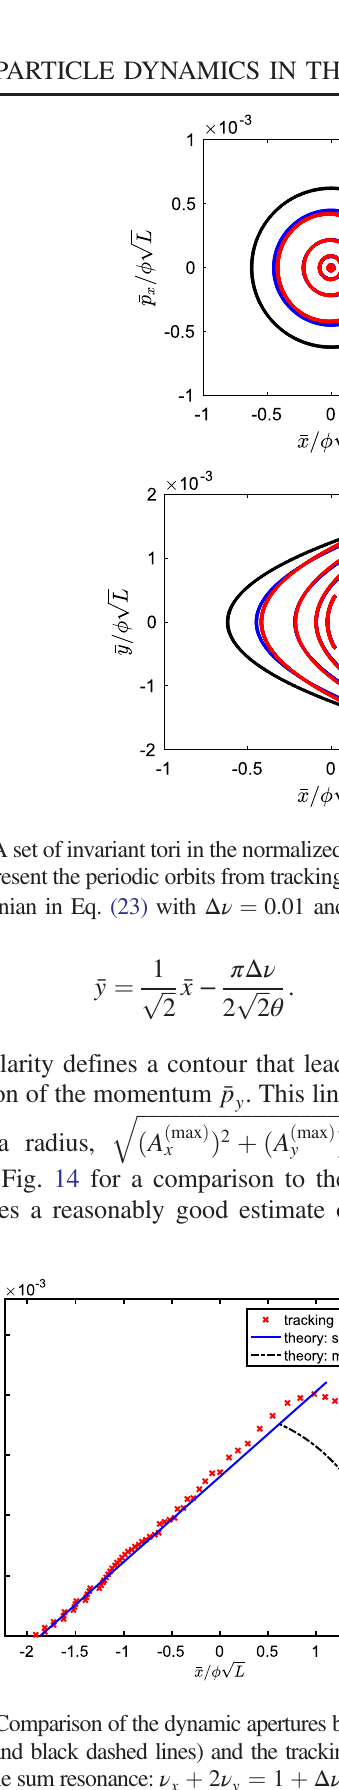
2 ν 1 þ Δ ν with Δ ν ¼ 0 . 01 x þ y ¼